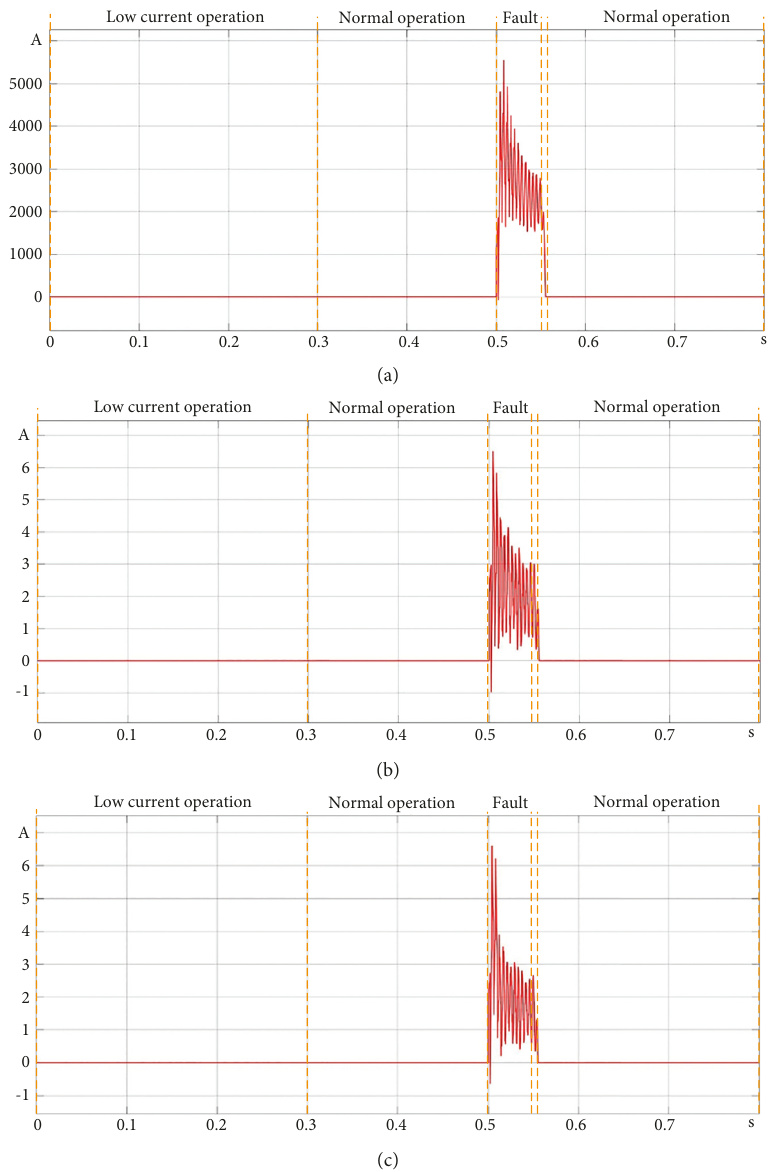
Figure 5: Fault current of the HVDC transmission line. (a) A 250kV HVDC transmission line (250 kV, 500kVA, 2kA), (b) a 450V HVDC transmission line (450 V, 750VA, 1.667A), and (c) a 500V HVDC transmission line (500V, 750 VA,